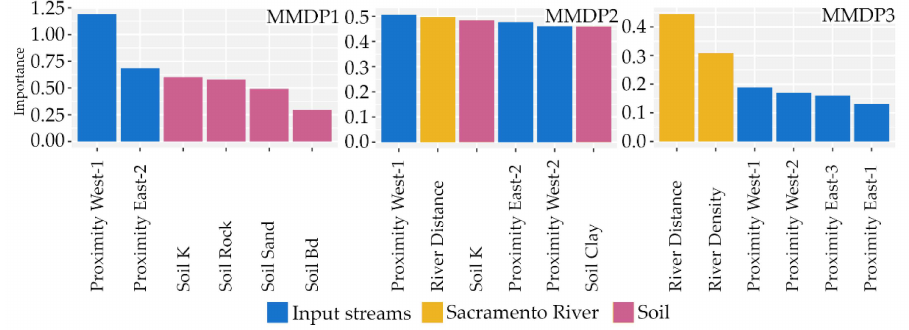
Figure 7. The six most important variables for each of the three MMDP RF models. The colours of the bars indicate the group to which each variable